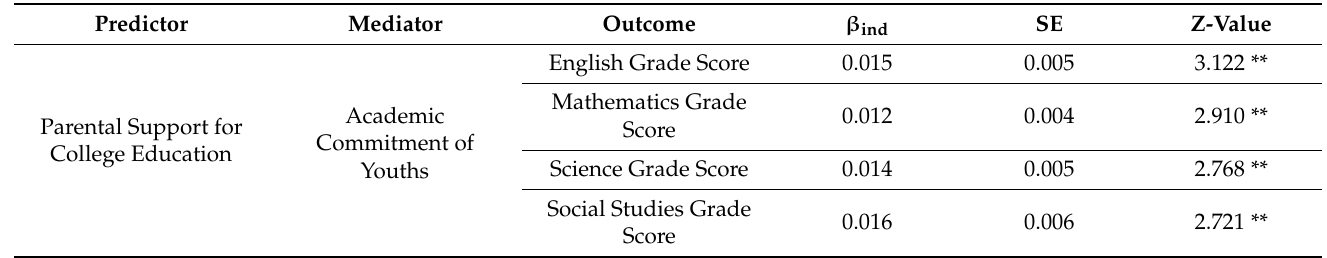
Table 2. Mediated effects of Grade-8 Academic Commitment of Youths on the Relationships of Grade-7 Parental Support for College Education, Family SES, and Educational Expectations of Youths in Prediction of Grade-9 Educational Performance of Youths in Model